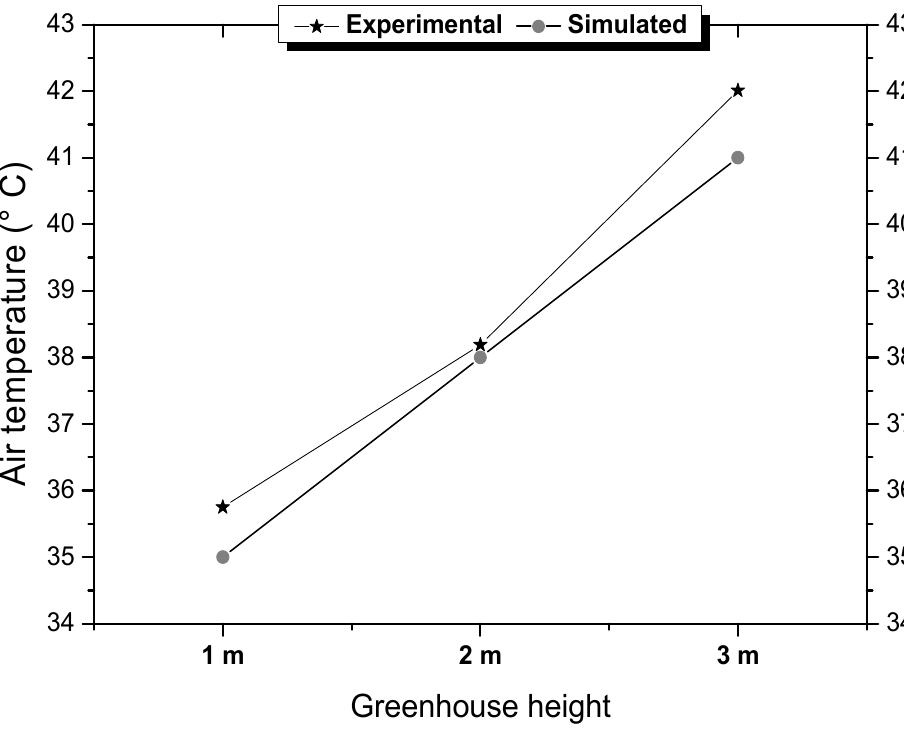
Figure 4. Simulated and measured air temperatures at three different heights (1 m, 2 m and 3 m) at noon on 15 February 2017.